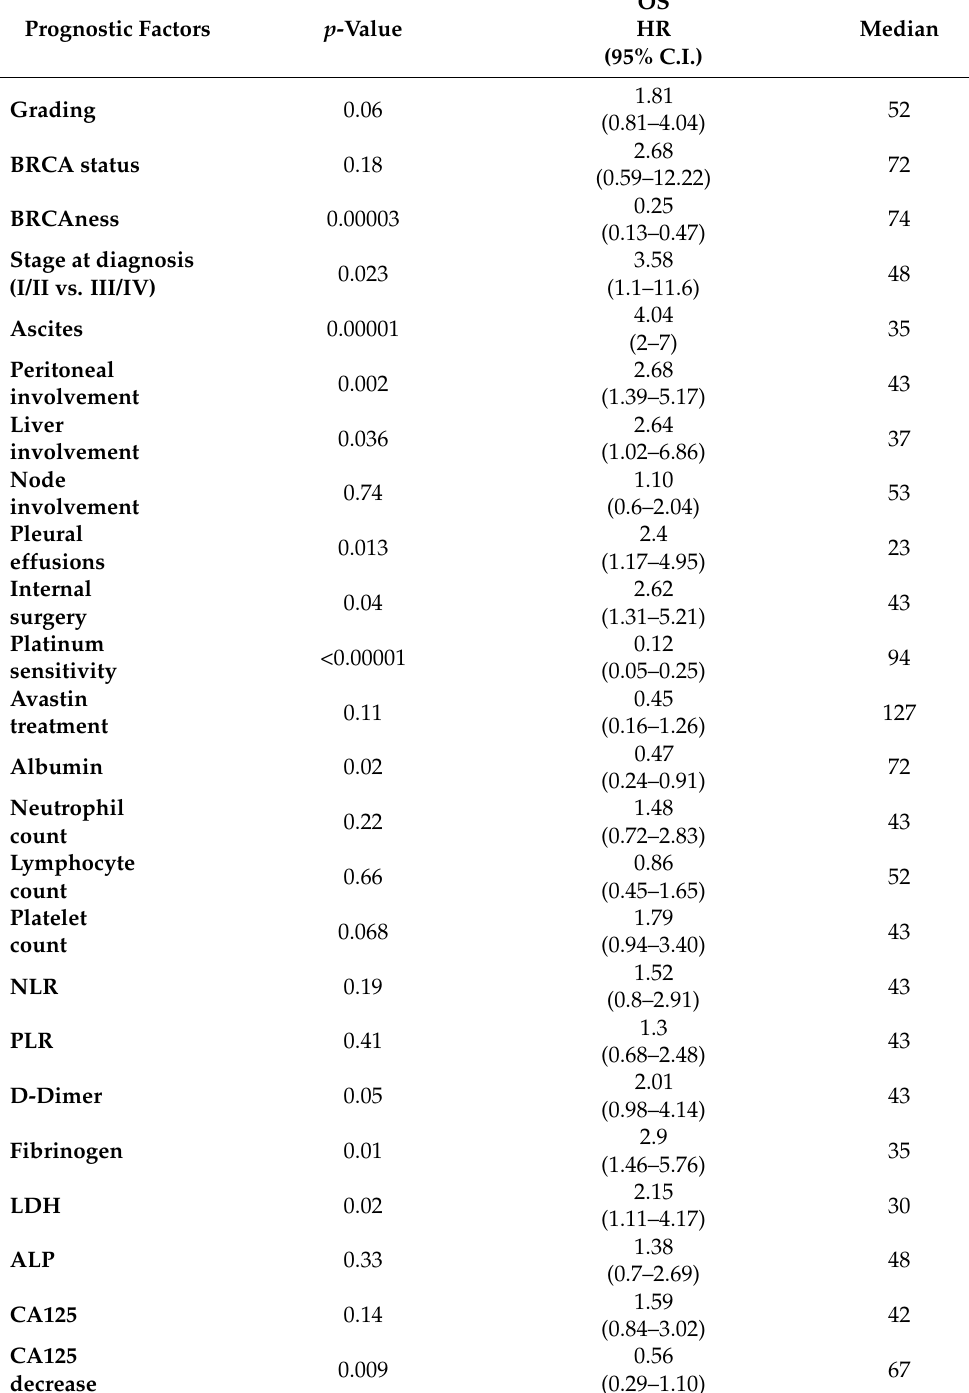
Table 3. Overall Survival (OS) for major prognostic factors. Table shows results summarised con- sidering the impact of each prognostic factor on survival obtained by univariate analysis by Log Rank